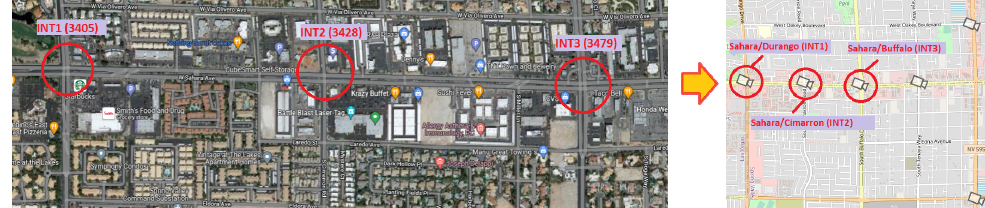
Figure 4. Three intersections with accessible traffic cameras targeted for automated monitoring and analysis.